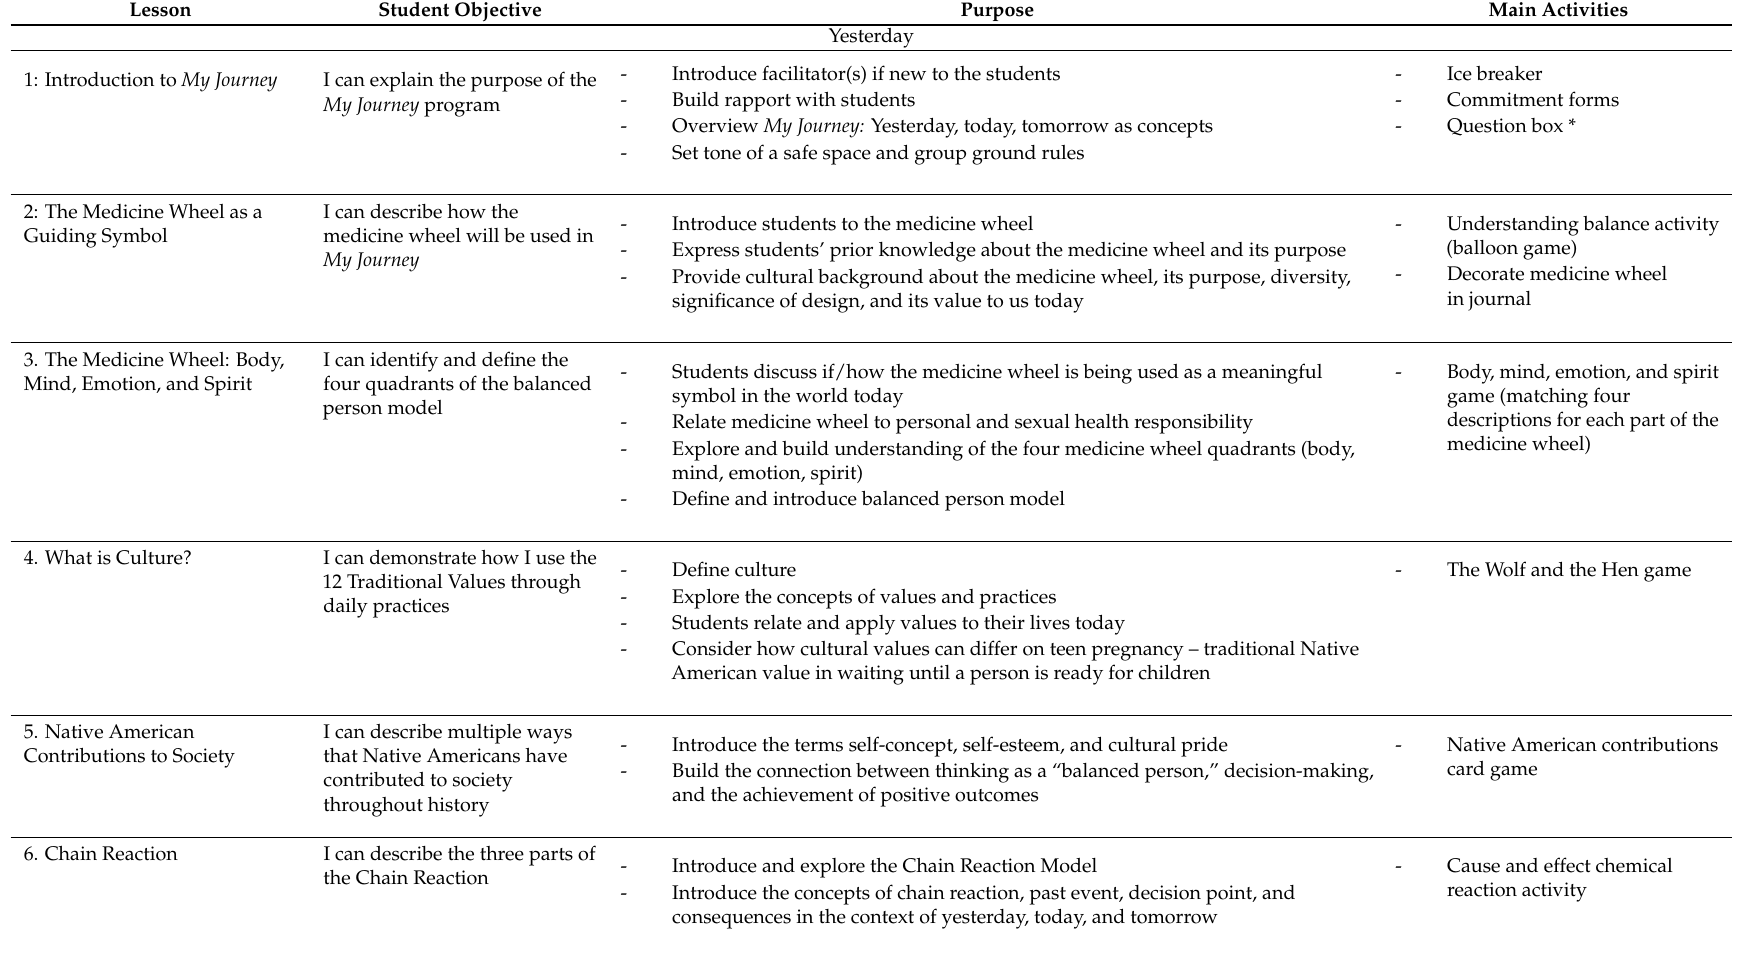
Table A1. My Journey Table of Contents with Corresponding Lesson Purpose and Main